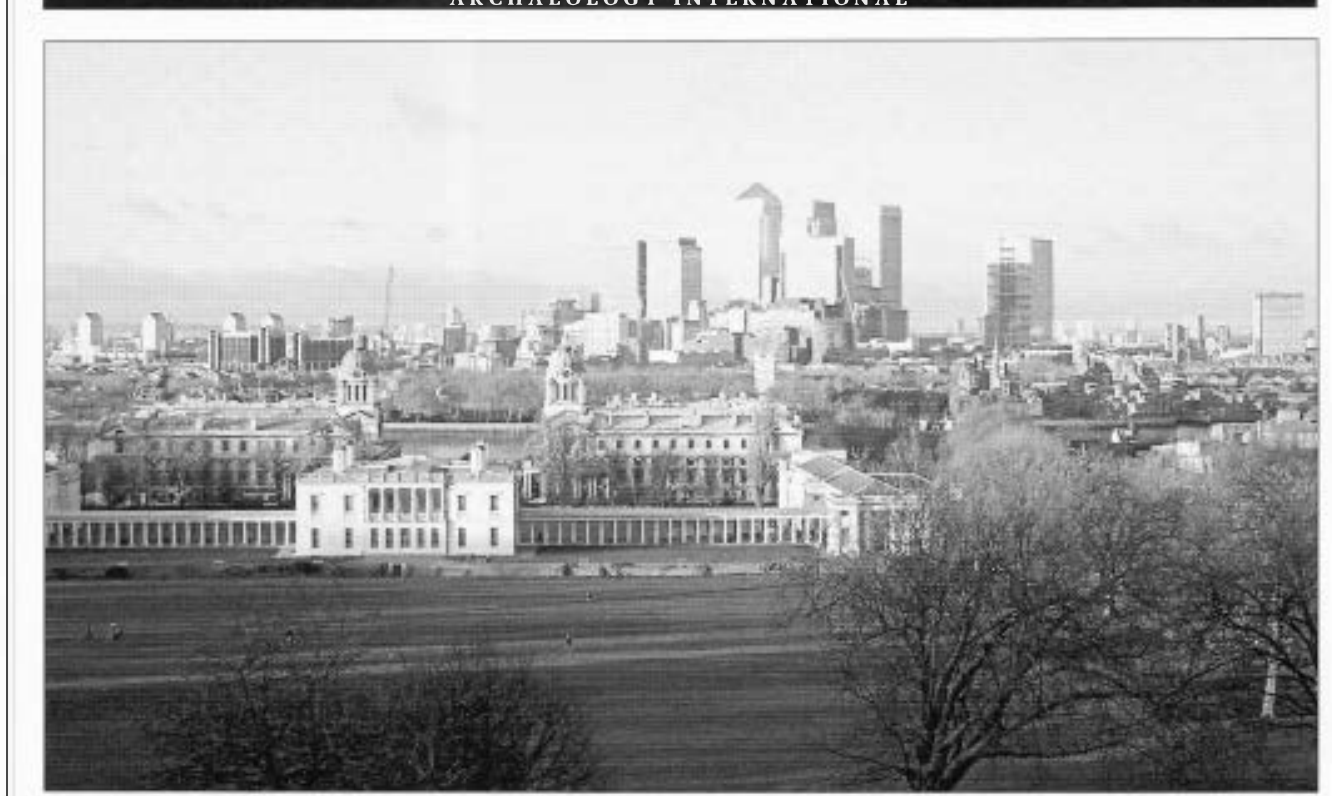
Figure 5 The classical buildings of the Royal Naval Hospital, Greenwich (southeast London}, now occupied by the National Maritime Museum, juxtaposed against the towering commercial complex of Canary Wharf across the River Thames. demands? These activities such as these leave unexploited the collections them­ selves, still the defining feature of a museum and a huge and costly